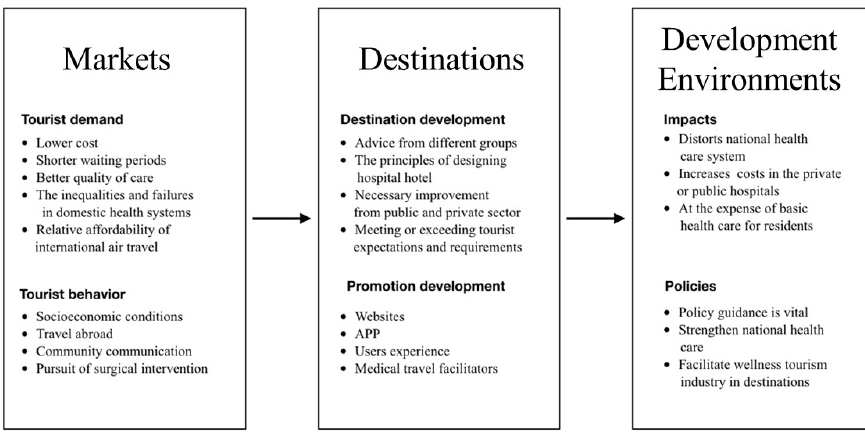
Figure 6. Timeline of research keyword appearance.